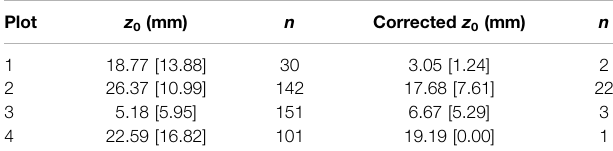
TABLE 4 | Summary of z 0WT (mm) from wind towers. Mean z 0WT for the entire measurement duration for each plot is shown, including mean z 0WT corrected for stability, with standard deviation (mm) in square brackets. n is the number of pro fi les that fi t MO similarity theory.